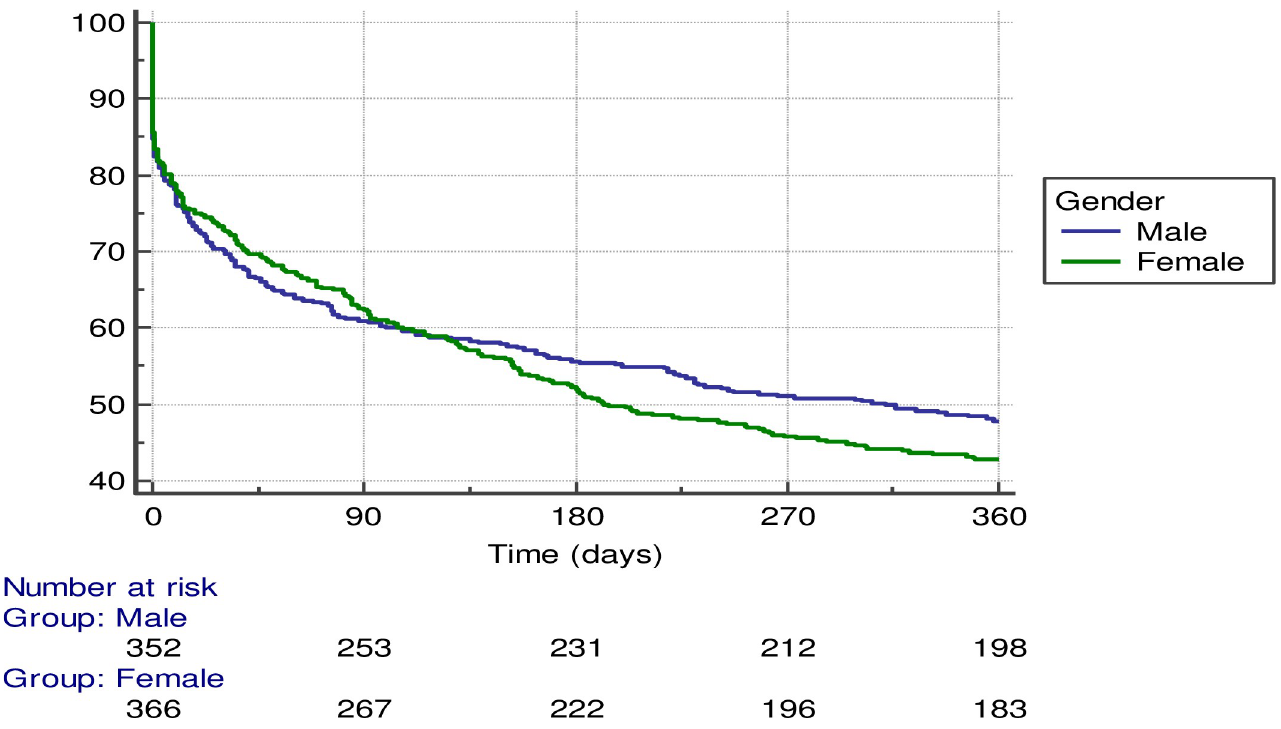
Fig 4. Kaplan-Meier survival curves and gender.